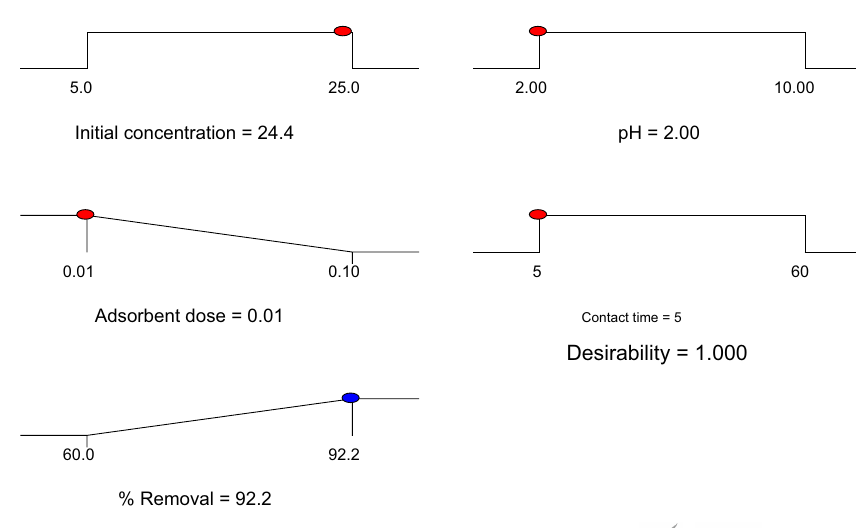
Fig. 6 Desirability (RAMP plot) for numerical optimization of four selected goals